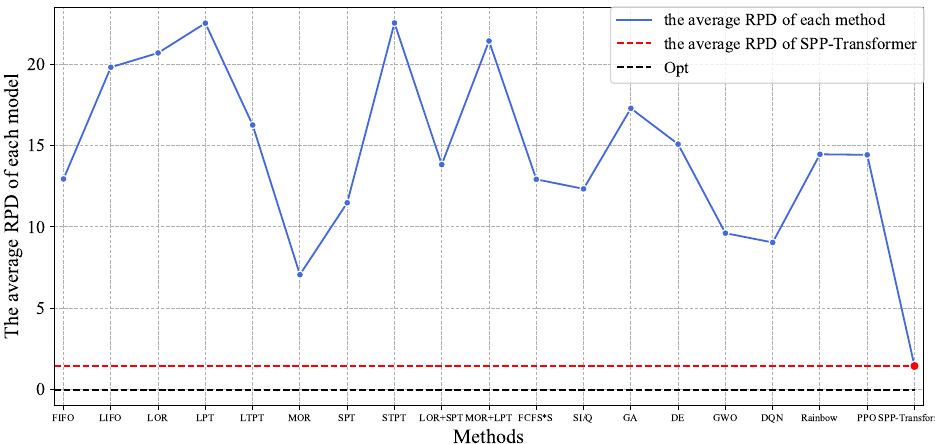
Figure 4. The average PRD(%) of each method on each instance. The red dotted line represents the average RPD of SPP-Transformer and it can be found that the average RPDs of the other 18 methods are above the red dotted line, representing that the average RPDs of the other 18 methods are larger than that of SPP-Transformer and SPP-Transformer outperforms the other 18 methods. Moreover, it can be found from Table 3 that the RPDs of SPP-Transformer on LA08-09, LA13, LA15-17, LA19-20 are